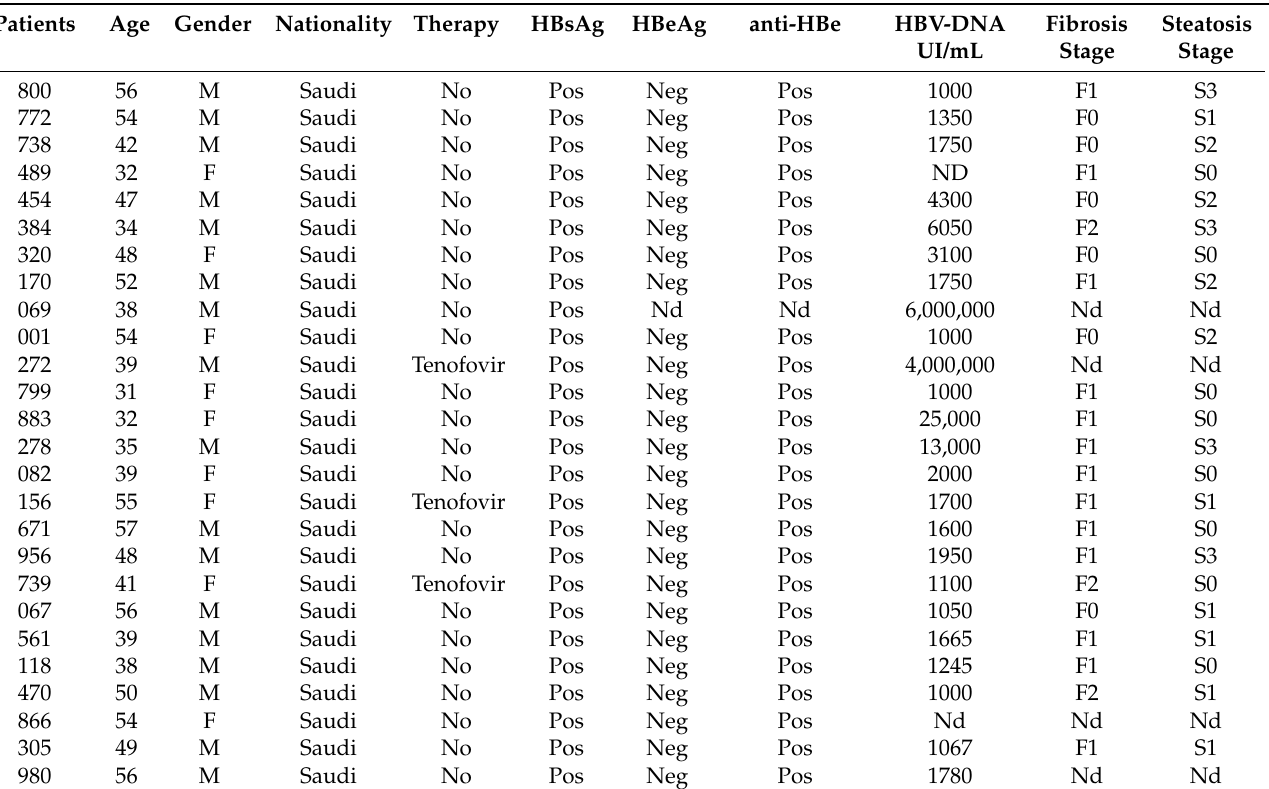
Table 1. Demographic, virological, and clinical characteristics of patients infected with